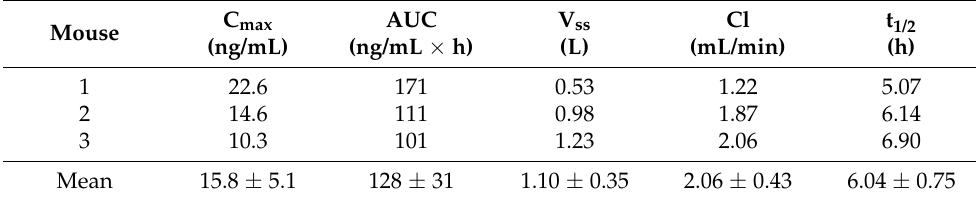
Table 1. Single-dose pharmacokinetics of intravenous actinomycin D in mice.